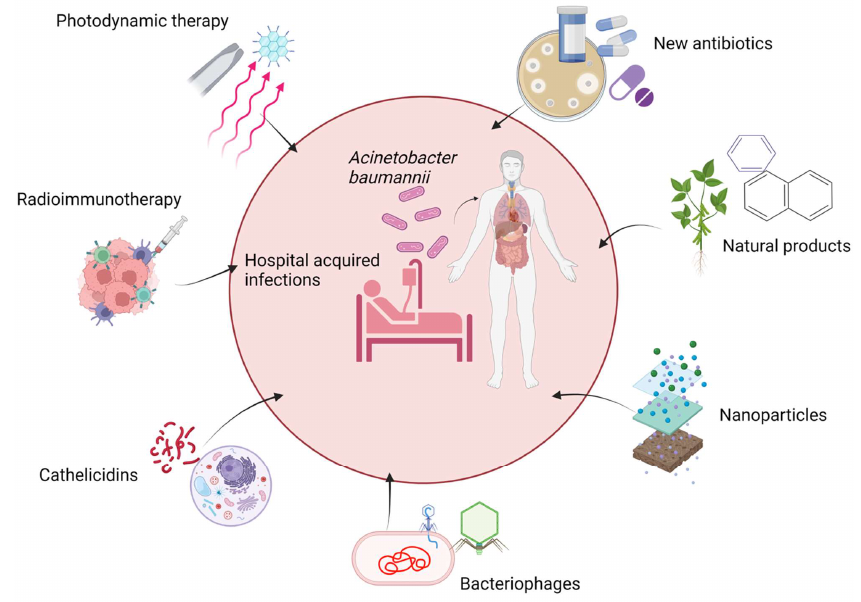
Figure 3. Possible future therapies for A. baumannii infection. The figure was made with www.bio- render.com (accessed on 25 July 2022). biorender.com (accessed on 25 July